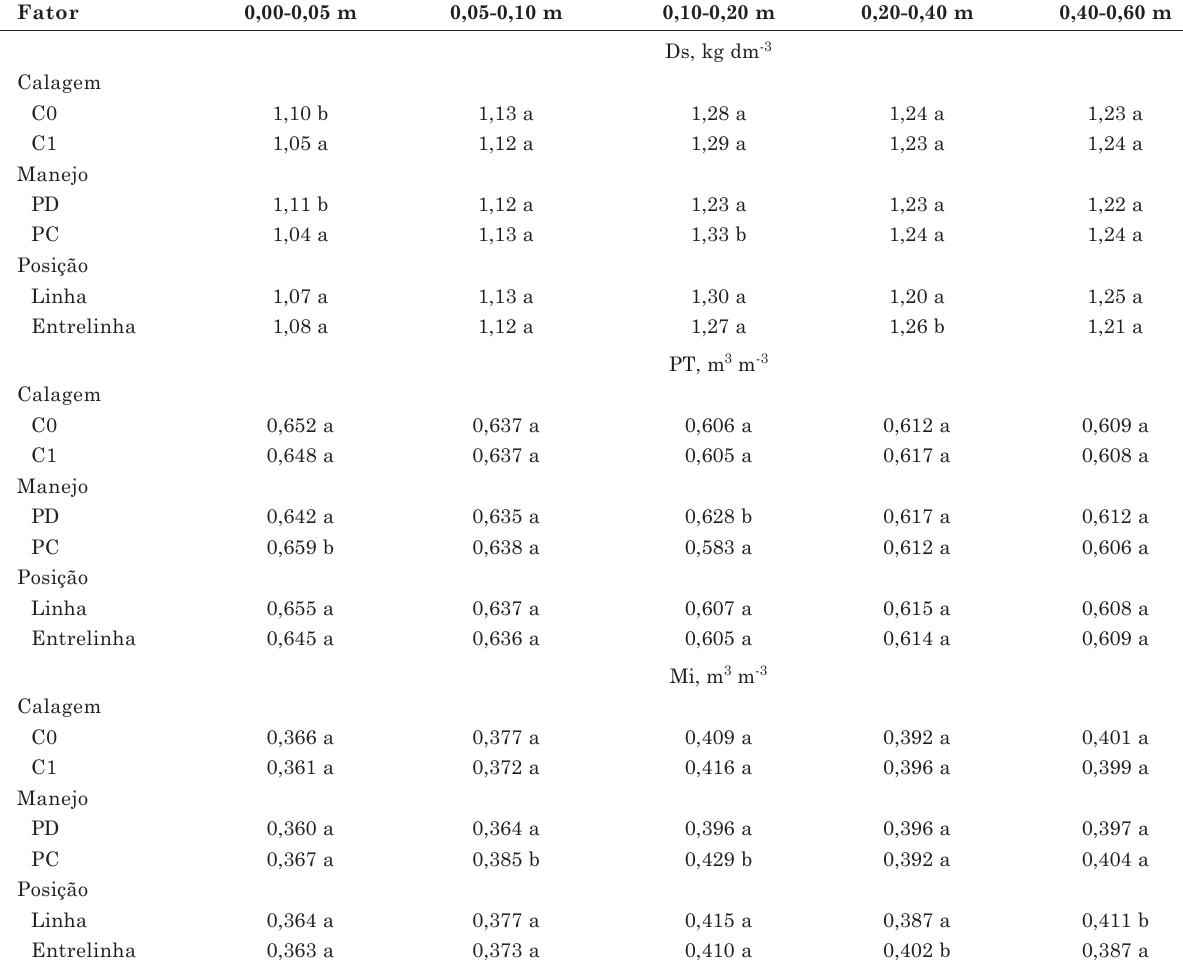
Quadro 1. Valores de densidade do solo (Ds), de porosidade do solo (PT) e de microporosidade do solo (Mi)